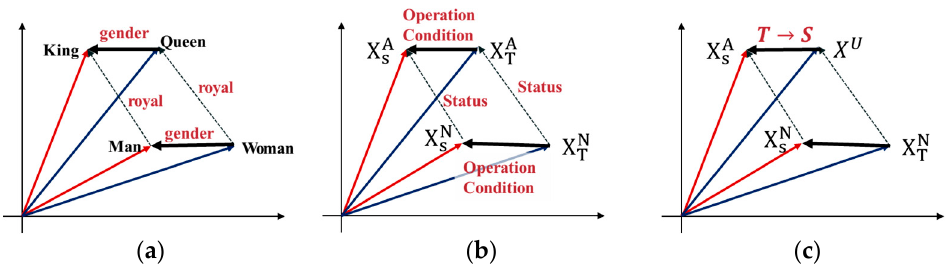
Figure 9. 2D representation of the semantic analogies. Word analogies for ( a ) vector operation, ( b ) latent vector operation, and ( c ) latent vector operation of unknown input data.